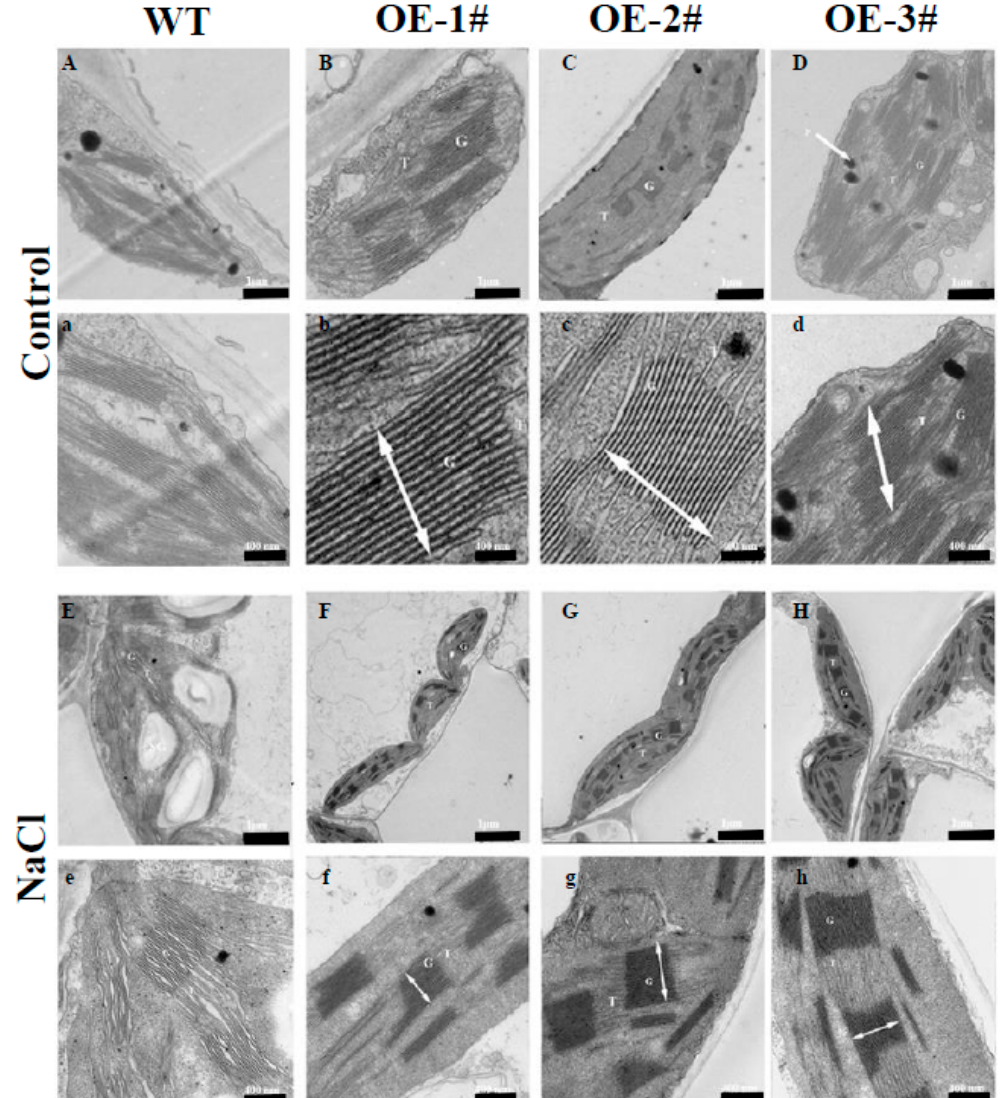
Figure 6. Electron microscopy in chloroplast of WT and CsTGase OE plants after salt stress. ( B – D , b – d , F – H and f – h ) shows an increased grana appression and a reduced stroma thylakoid network with respect to the WT ( A , a , E , e ) under normal conditions and salt stress. G, grana; T, thylakoid; SG, starch grana, P, plastoglobule. Grana height is indicated by white arrows. Scale bars for chloroplast and thylakoid are indicated. Three biological replicates were performed, and similar results were obtained.